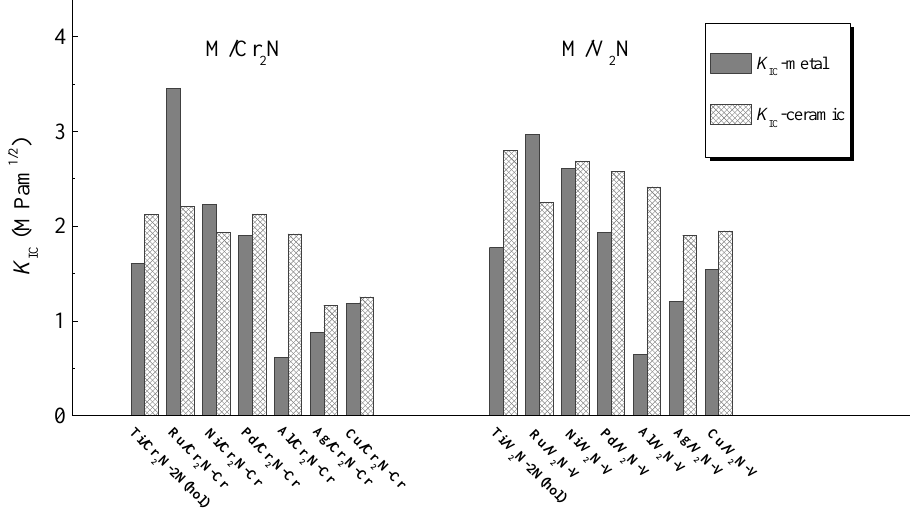
Figure 9. The K IC -metal and K IC -ceramic obtained for the interface models after full relaxation.